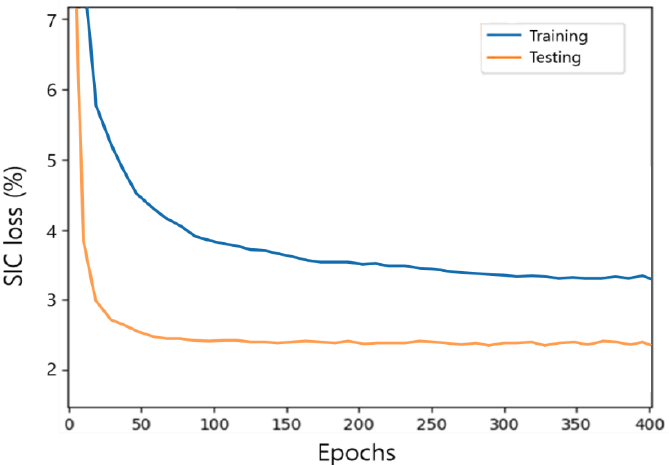
Figure 8. SIC loss versus number of epochs for training and testing processes in the proposed SIC scheme.